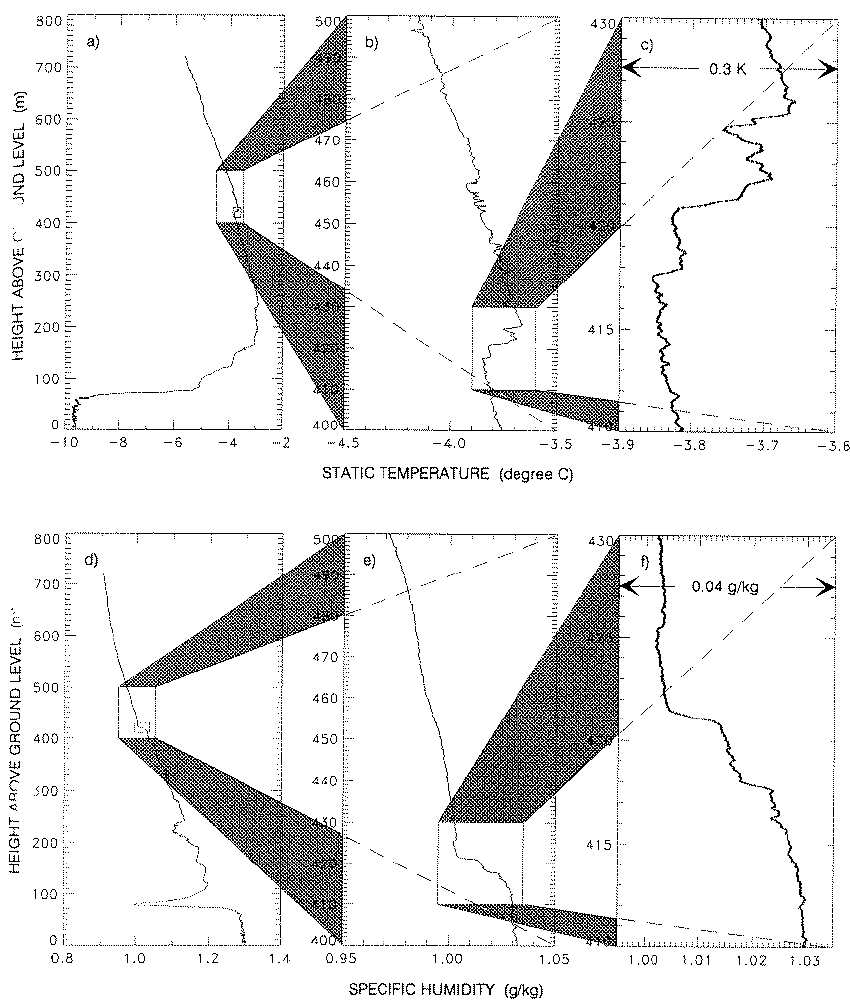
Fig. 15. Three successive close-ups of temperature (a)–(c) and humidity (d)– (f) profiles measured within the bound- ary layer with helicopter born high- resolution sensors indicating submeter sheets, e.g. at 417 and 426m (after Muschinski and Wode,